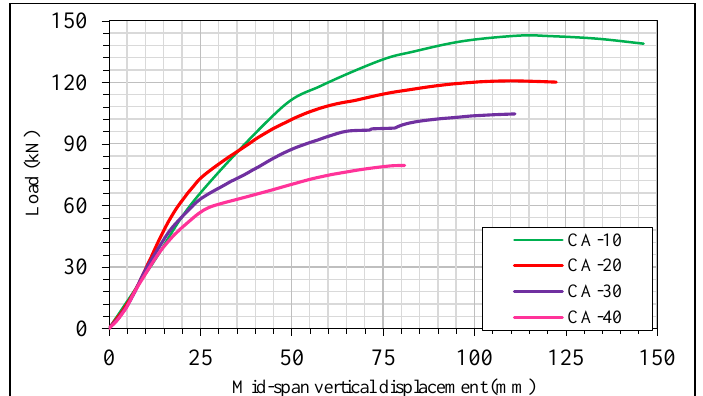
Figure 10. Span/radius of ratio effect on the load-deflection curve of the curve composite